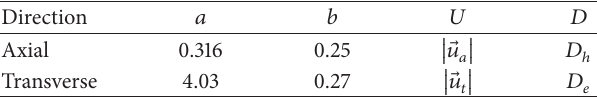
󵄨󵄨󵄨󵄨 󵄨󵄨󵄨󵄨 ⃗𝑢 𝐷 𝑎 ℎ 󵄨󵄨󵄨󵄨 󵄨󵄨󵄨󵄨 ⃗𝑢 𝐷 𝑡 𝑒